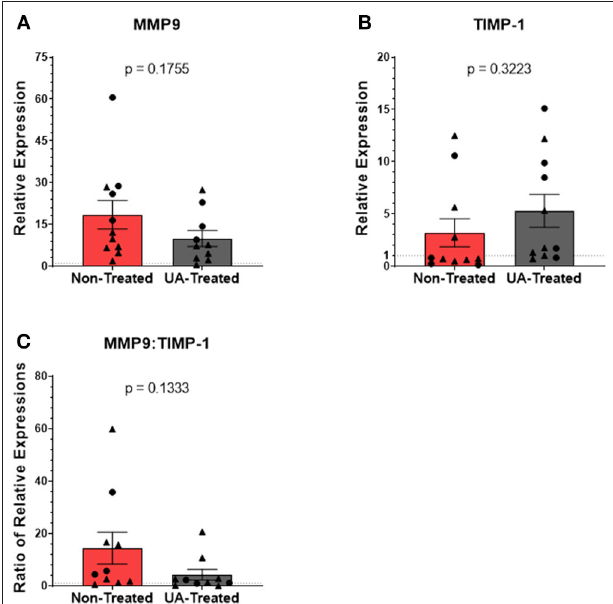
FIGURE 6 | Prophylactic UA treatment alters matrix metalloproteinase activity in the lungs following MH infection. Samples of lung tissue were collected at necropsy and stored in RNAlater solution for qPCR analysis of (A) MMP9 and (B) TIMP-1 mRNA expression; individual animal data from F2019 has been represented as a circle (•), while S2020 animal data has been represented as a triangle ( N ). The relative mRNA expression in pneumonic lung tissue from non-treated and UA-treated animals was compared to healthy lung tissue from control animals (F2019 group) for both studies. Graphs depict the average relative expression (RE) ± the SEM for each treatment group across both studies. Outliers in the data sets were first identified using the ROUT method (Prism v9.1.0), and the data were analyzed by standardized unpaired t -test (* p < 0.05). (A) Non-treated n = 11, UA-treated n = 10; (B) non-treated n = 11, UA-treated n = 11). (C) Depicts the ratio of MMP9 to TIMP-1 RE for each individual animal. Data represent mean RE ratios ± the SEM for each treatment